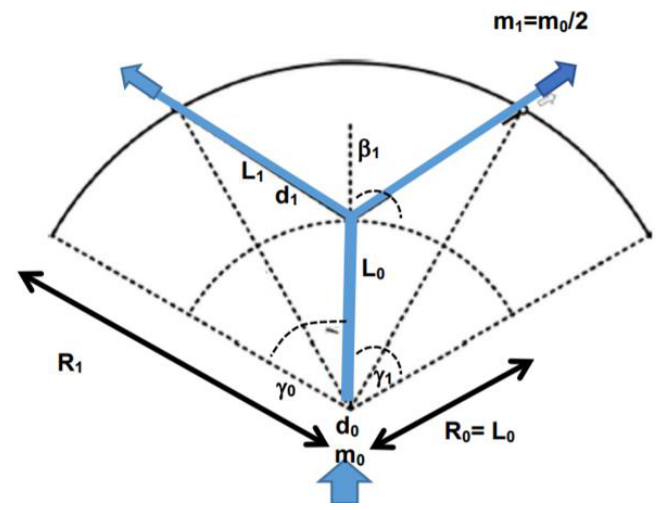
Figure 4. DSHE nomenclature (here, z 0 = 3, z b = n = 1, γ 0 = 60°).